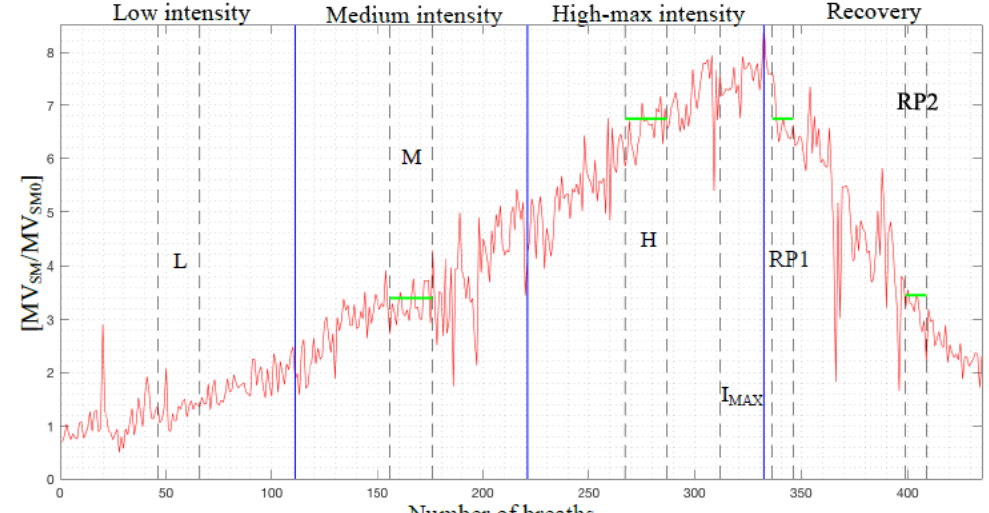
Figure 9. Normalized minute ventilation signal and regions identified, exercise test and recovery (healthy female subject, 38 years old, 165 cm, 52 kg). The green segments indicate the correspondence of normalized minute ventilation values between RP1 and H, and RP2 and M sections, respectively.